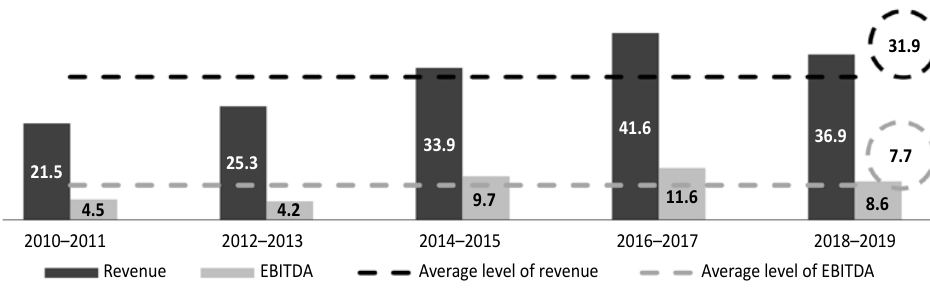
Source: own elaboration based on Kolarova et al. (2020, p.